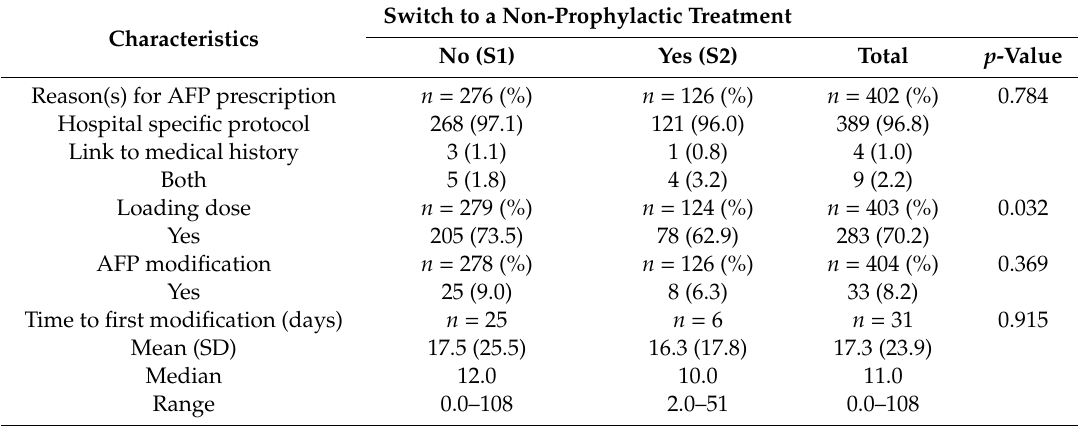
Figure 2. ( A ) Initially prescribed molecules for antifungal prophylaxis ( B ) First antifungal prophylaxis modification per patient. Table 3. Initial AFP treatment and modifications.